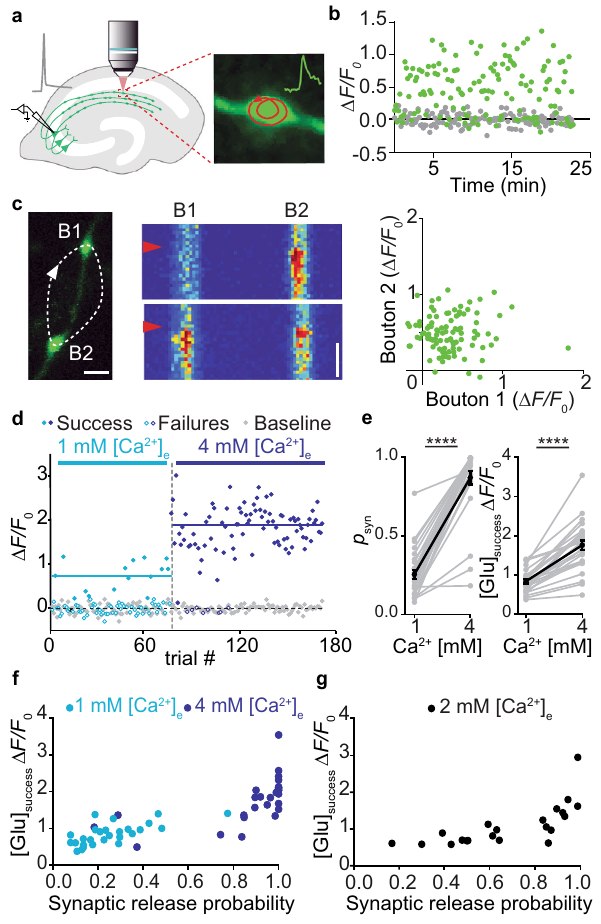
Fig. 1 | Increased release probability increases the glutamate concentration of synaptic transmission events. a CA3 pyramidal neuron in organotypic slice cul- ture was patch-clamped to somatically trigger single action potentials while ima- ging with2-photonlaserscanningmicroscopy bouton fl uorescenceinCA1stratum radiatum. b Response amplitude (green circles) monitored in arti fi cial cere- brospinal fl uid (ACSF) containing 2mM [Ca 2+ ] e at 33°C was constant over time. Baseline fl uorescence before stimulation was analyzed to estimate imaging noise (gray circles). c Monitoring two neighboring boutons located on the same axon. Scale bar, 1 µ m. Two trials showing independent release events. Red arrowheads indicate the stimulation onset. Scale bar, 20ms. iGluSnFR transients between neighboring boutons were not correlated (two-sided Spearman correlation: r = − 0.04, p =0.69). d Glutamatetransientsinasinglebouton,switchingfromACSF containing 1mM [Ca 2+ ] e to 4mM [Ca 2+ ] e . The light and the dark blue line represent the average amplitude of successes in 1mM [Ca 2+ ] e and 4mM [Ca 2+ ] e , respectively. e Summary of all [Ca 2+ ] e switching experiments. The probability of successful glu- tamaterelease(leftpanel)increasedfrom0.26±0.03in1mM[Ca 2+ ] e to0.87±0.04 in4mM[Ca 2+ ] e (two-sidedWilcoxon-signedranktest, p <0.0001, n =27bouto n sin 23 slices). The amplitude of fl uorescence transients in trials classi fi ed as ‘ success ’ (right panel) increased from 0.84±0.056 Δ F / F 0 in 1mM [Ca 2+ ] e to 1.76±0.12 Δ F / F 0 in 4mM [Ca 2+ ] e (paired t test, p <0.0001, n =27 boutons in 23 slices). Values are